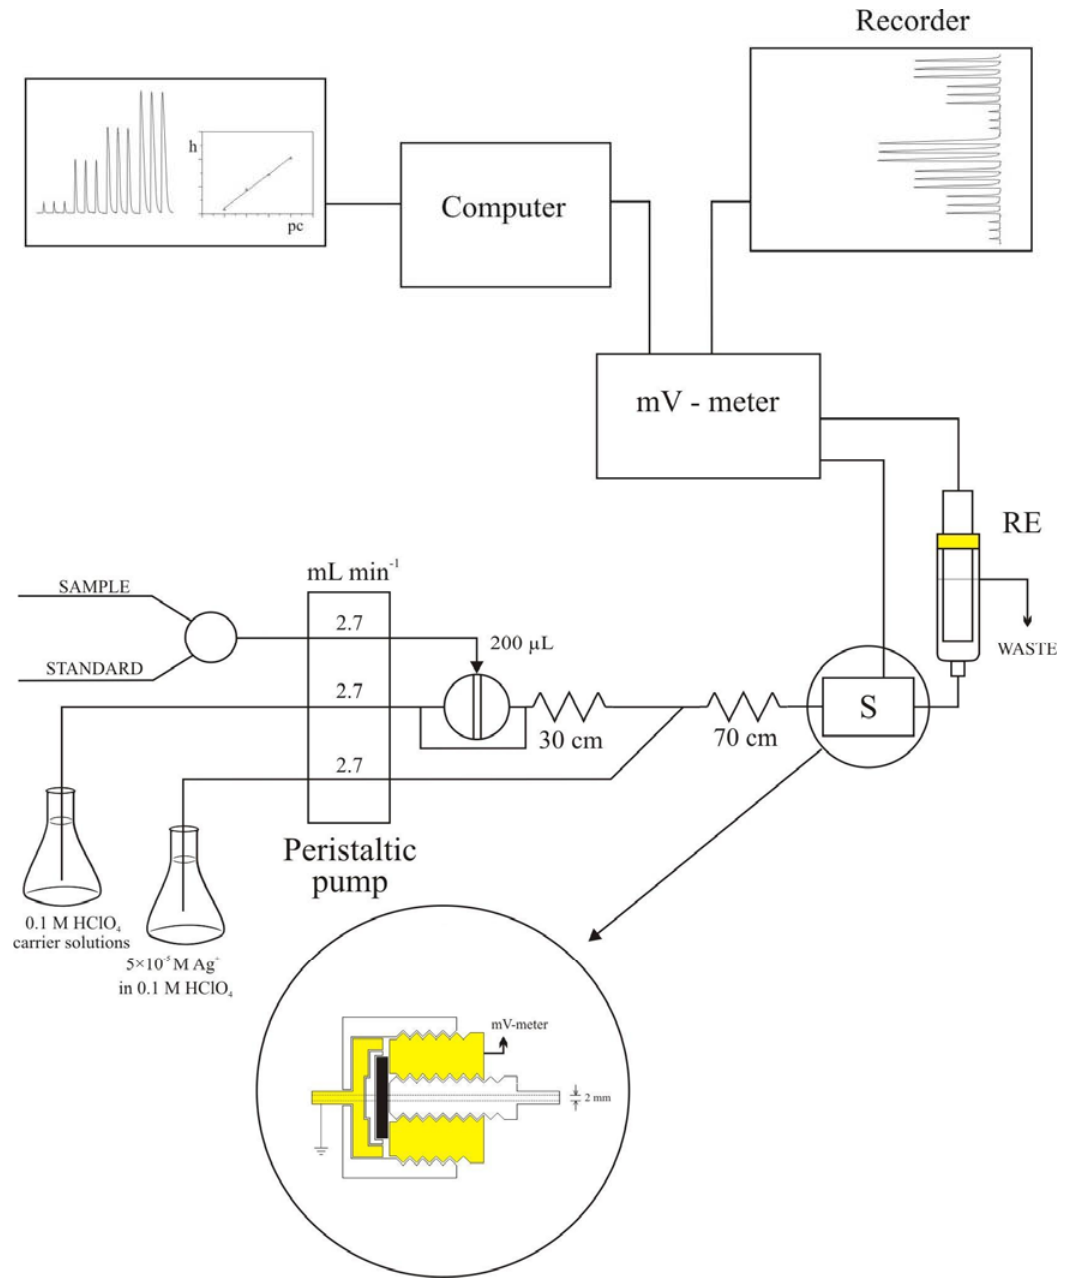
Figure 8 . Schematic image of flow-injection system with tubular potentiometric sensor based on